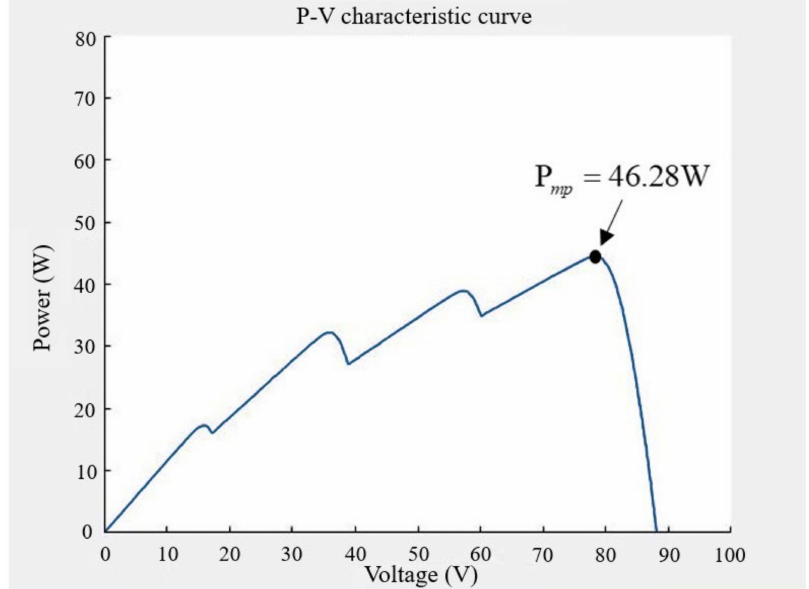
Figure 10. P–V characteristic curve simulation for Case 4.